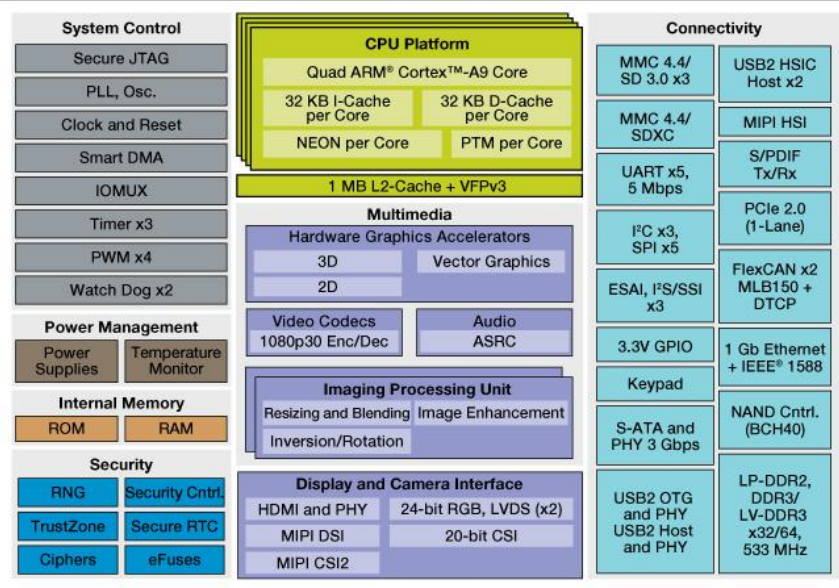
Figure 7. Architecture of the processor used in the main unit of